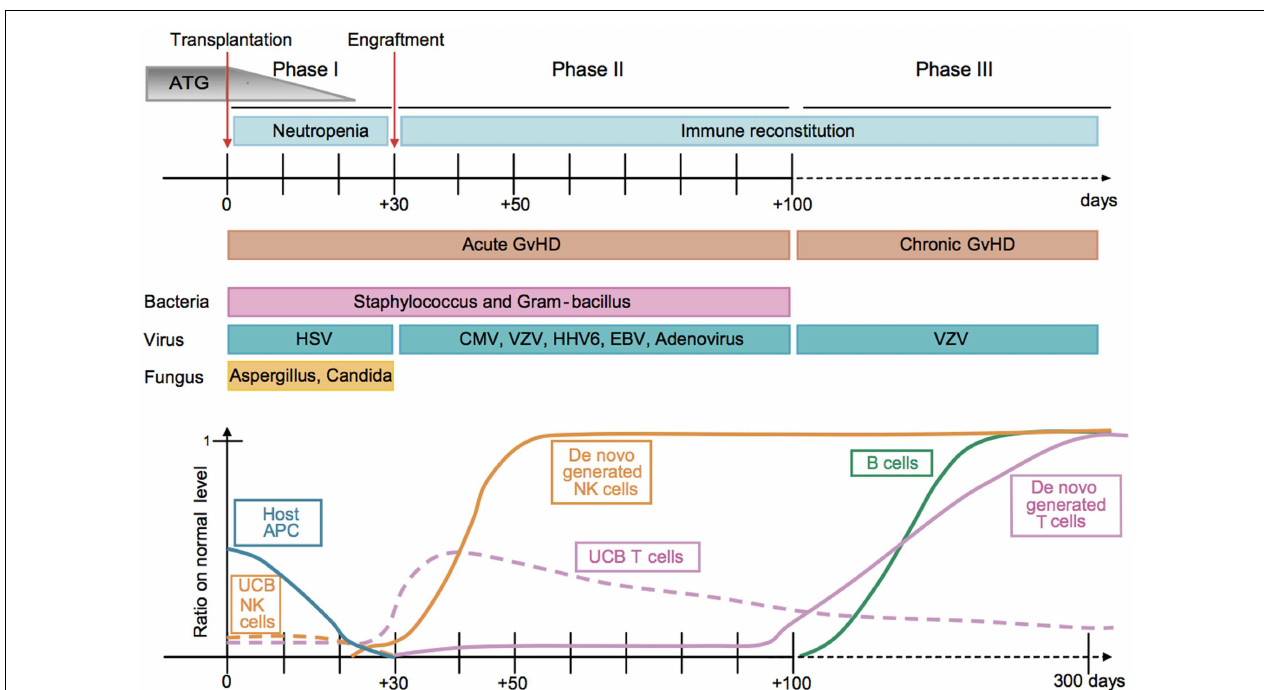
experience high susceptibility to bacterial infections, viral infections (i.e., CMV), and acute GvHD. Some UCBT cells are believed to persist in the recipient and proliferate through HE.This period culminates with the de novo generation ofT cells through thymopoiesis and the end of the 100-day high-risk window.The late phase (Phase III) is characterized by a higher incidence ofVZV infection/reactivation and a progressive reconstitution of B cell andT-cell subsets, which can reach normal levels at 6–9months post- transplant [figure and legend originally published by Merindol and colleagues (226); used with the permission of H. Soudeyns and the Journal of Leukocyte Biology (Copyright FASEB Office of Publications, Bethesda, MD,